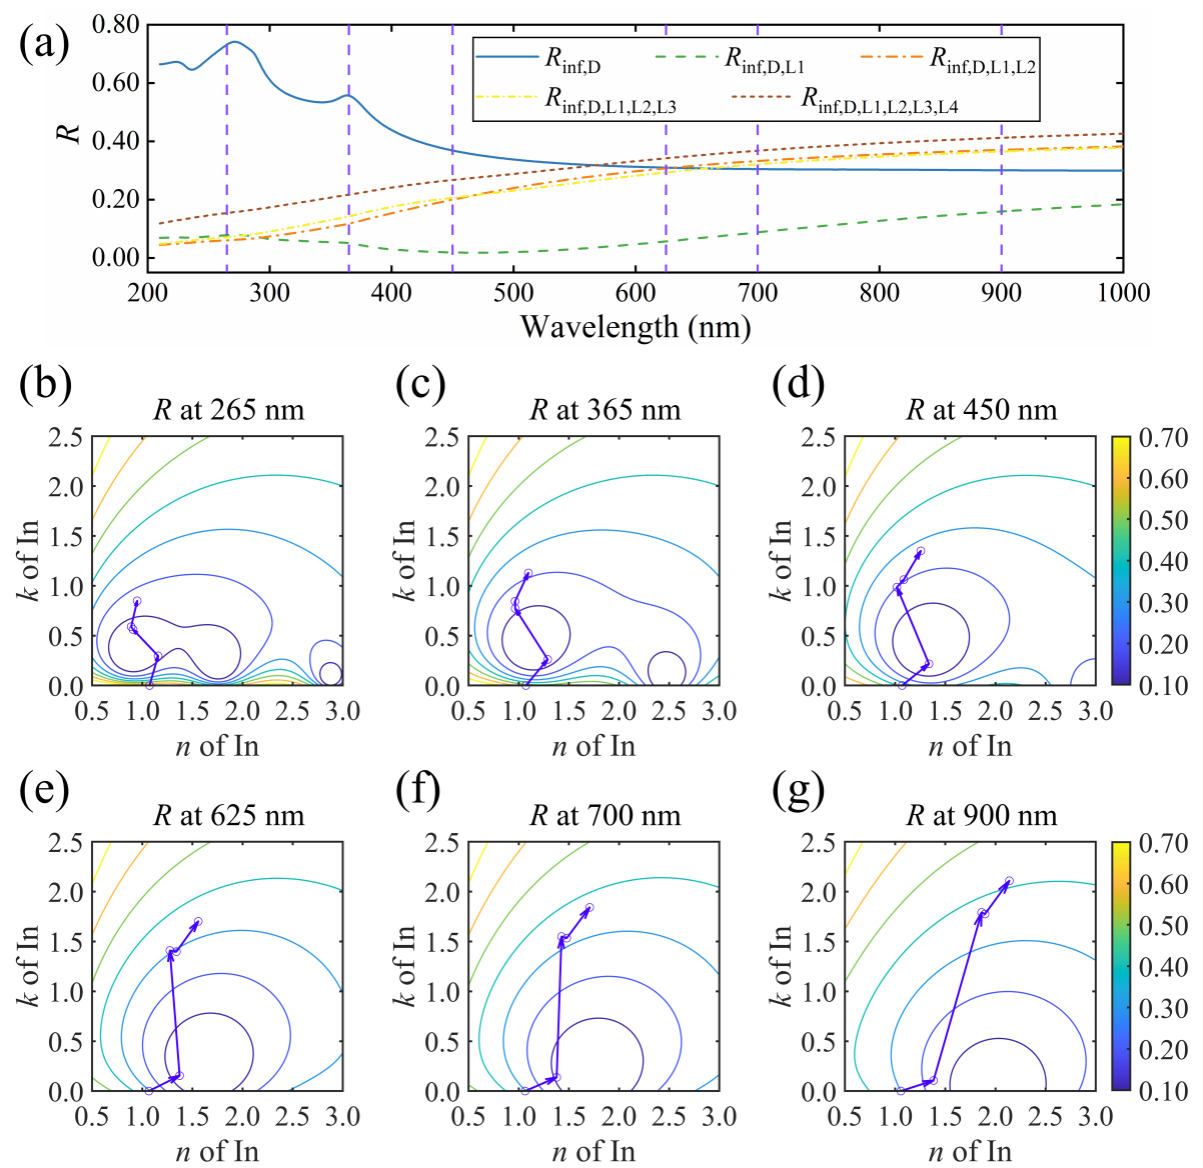
Figure 6. Reflectance spectra with different Lorentz oscillator components for ( a ) S6, and oscillator decomposition at a wavelength of ( b ) 265, ( c ) 365, ( d ) 450, ( e ) 625, ( f ) 700 and ( g ) 900 nm. Curves in ( b – g ) are the contour lines of reflectance.